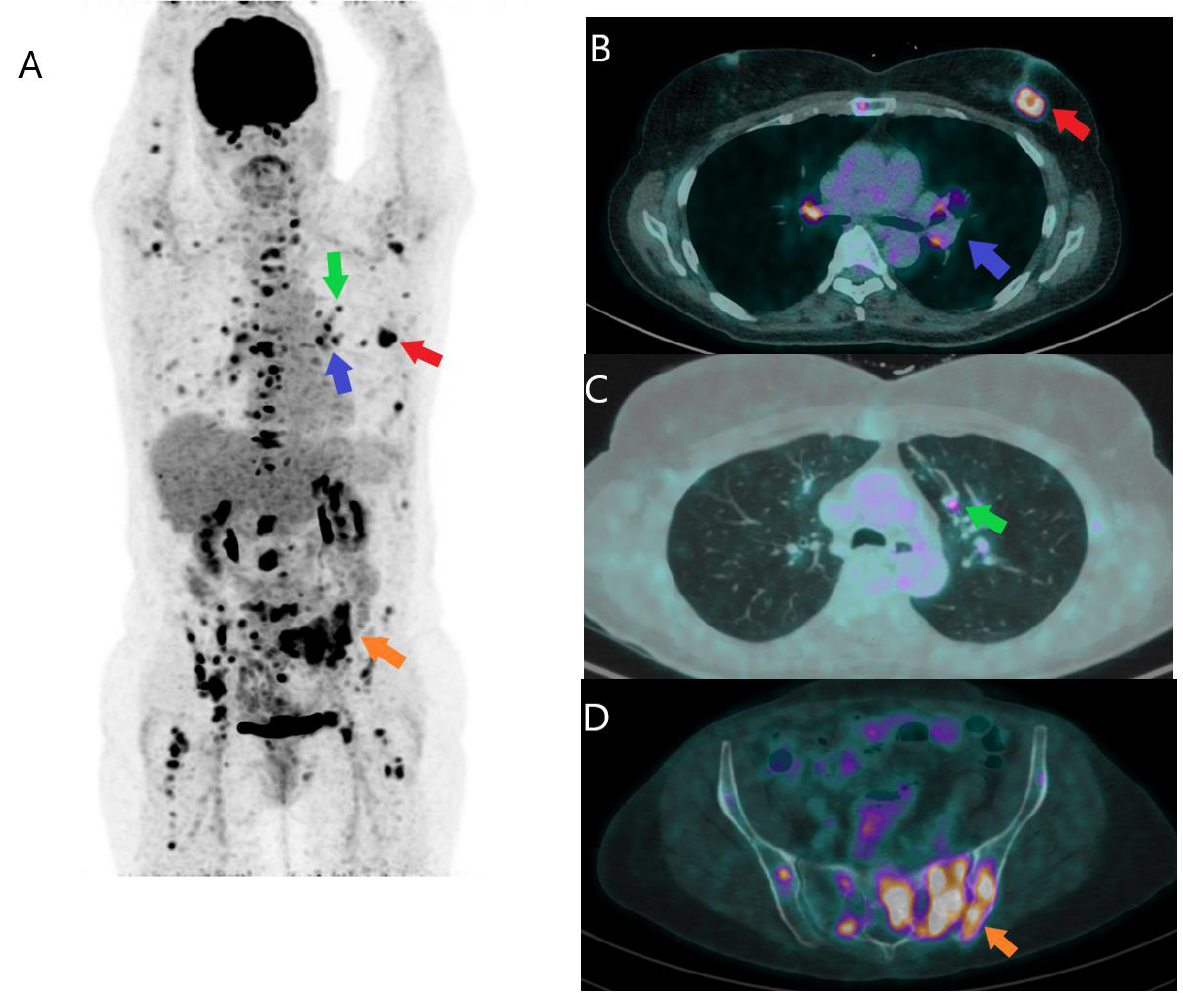
Figure 2. FDG PET/CT in initial staging. A 41-year-old woman with a newly diagnosed triple nega- tive left breast invasive ductal carcinoma of 21 mm, was referred for initial staging with FDG PET/CT. The PET/CT MIP image ( A ) shows the primary cancer (red arrow), mediastinal and hilar adenopathies (violet arrow), lung metastases (green arrow), and extensive bone involvement (orange arrow). Image ( B ) (fusion image, trans-axial view) shows the primary lesion of the left breast with necrotic center (red arrow) and the bilateral mediastinal and hilar adenopathies (violet arrow). Image ( C ) (fusion image, trans-axial view) shows a lung nodule in left upper lobe (green arrow). Image ( D ) (fusion image, trans-axial view) shows extensive bone involvement of sacrum and ilium (orange arrow).